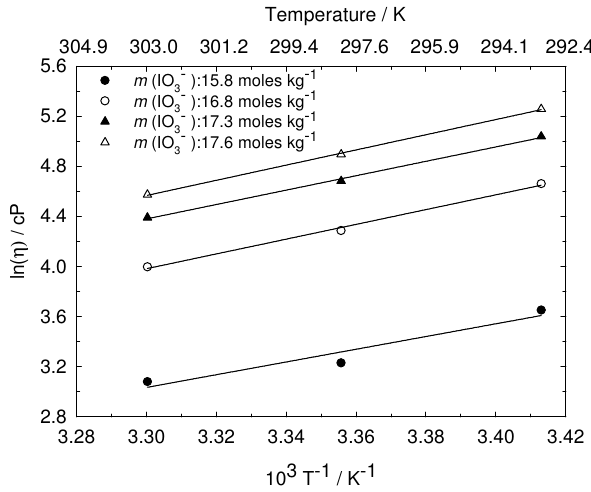
Fig. 5. Measured viscosity data for aqueous iodate solutions as a function of temperature, and associated linear fits (solid lines) us- ing an Arrhenius equation of the form, ln( η )=ln A + ( E a / RT ) – see Table 2 for fitted values of A , (the pre-exponential viscosity coeffi- cient), and E a , (the activation energy).